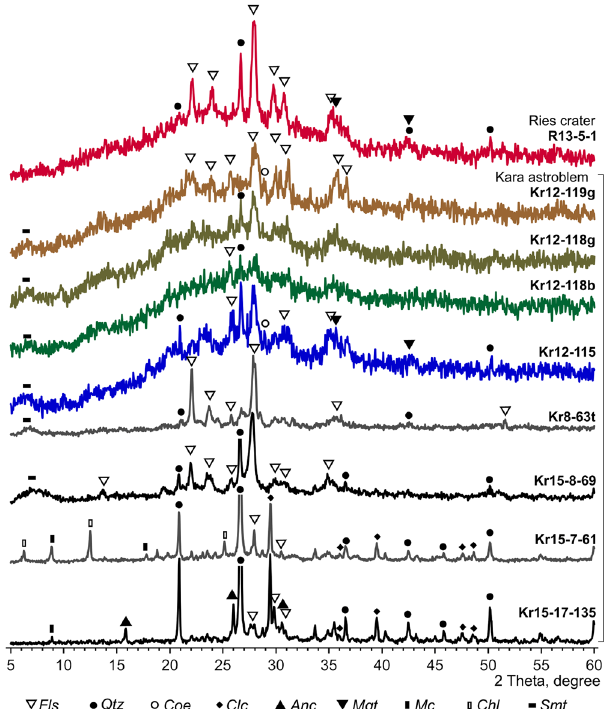
Figure 4. Diffraction patterns of solidified impact melts with different level of crystallinity. Fls – feldspar, Qtz – quarts, Coe – coesite, Clc – calcite, Anc – analcim, Mgt – magnetite, Mc – mica, Chl – chlorite, Smt –